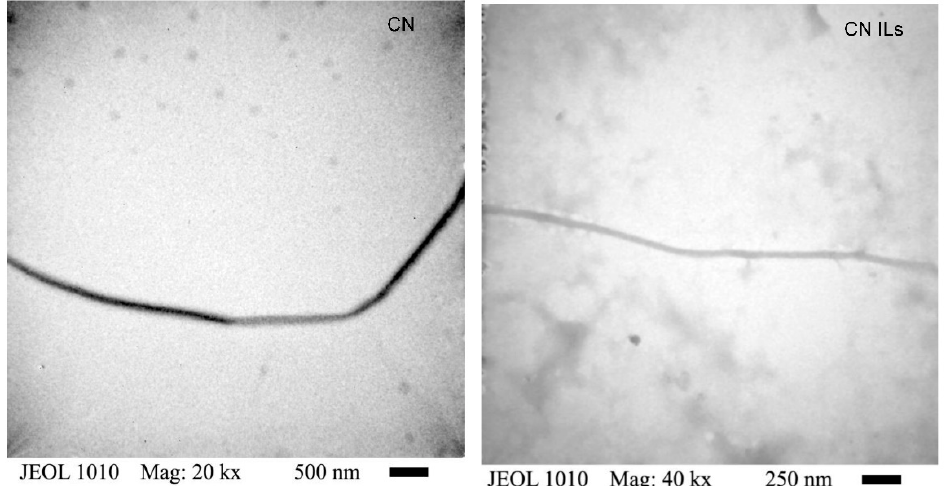
Figure 2. TEM micrograph of cellulose nanofiber from agave bagasse with organic solvent (CN) diameter of 88 nm, cellulose nanofiber from agave bagasse with ionic liquids (CN ILs) with diameter of 41.47 nm from electrospinning technique.